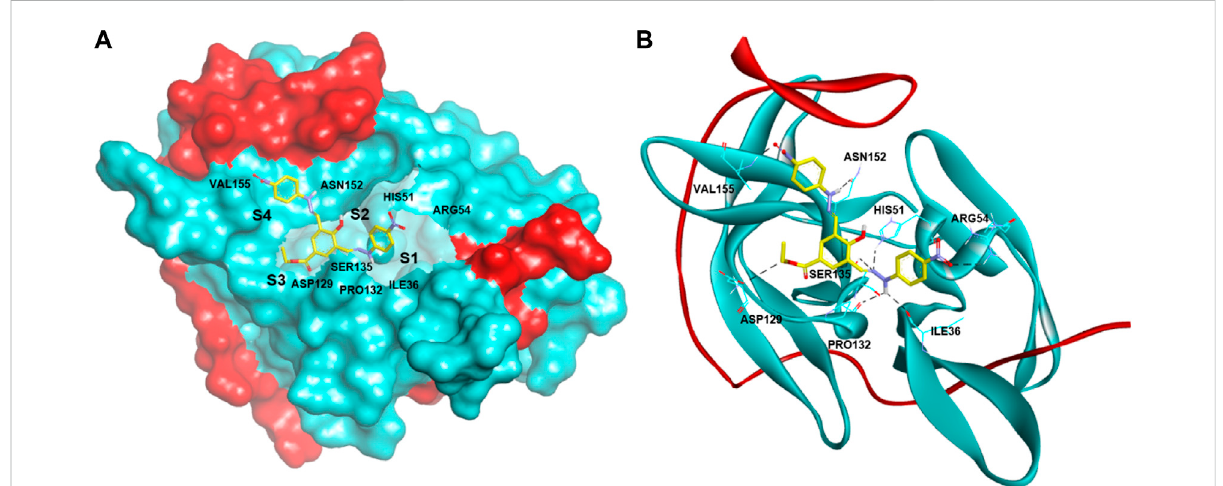
FIGURE 2 Dockingofactive compound 22a havingquinolinescaffold against DENV2NS2B-NS3protease with Δ G bind of-9.36 kcal/molin (A) surfaceand (B) ribbonprotein models. The red and cyan areas represent theNS2Band NS3 protease chains, respectively. The H-bond interactions are shown as black dashed